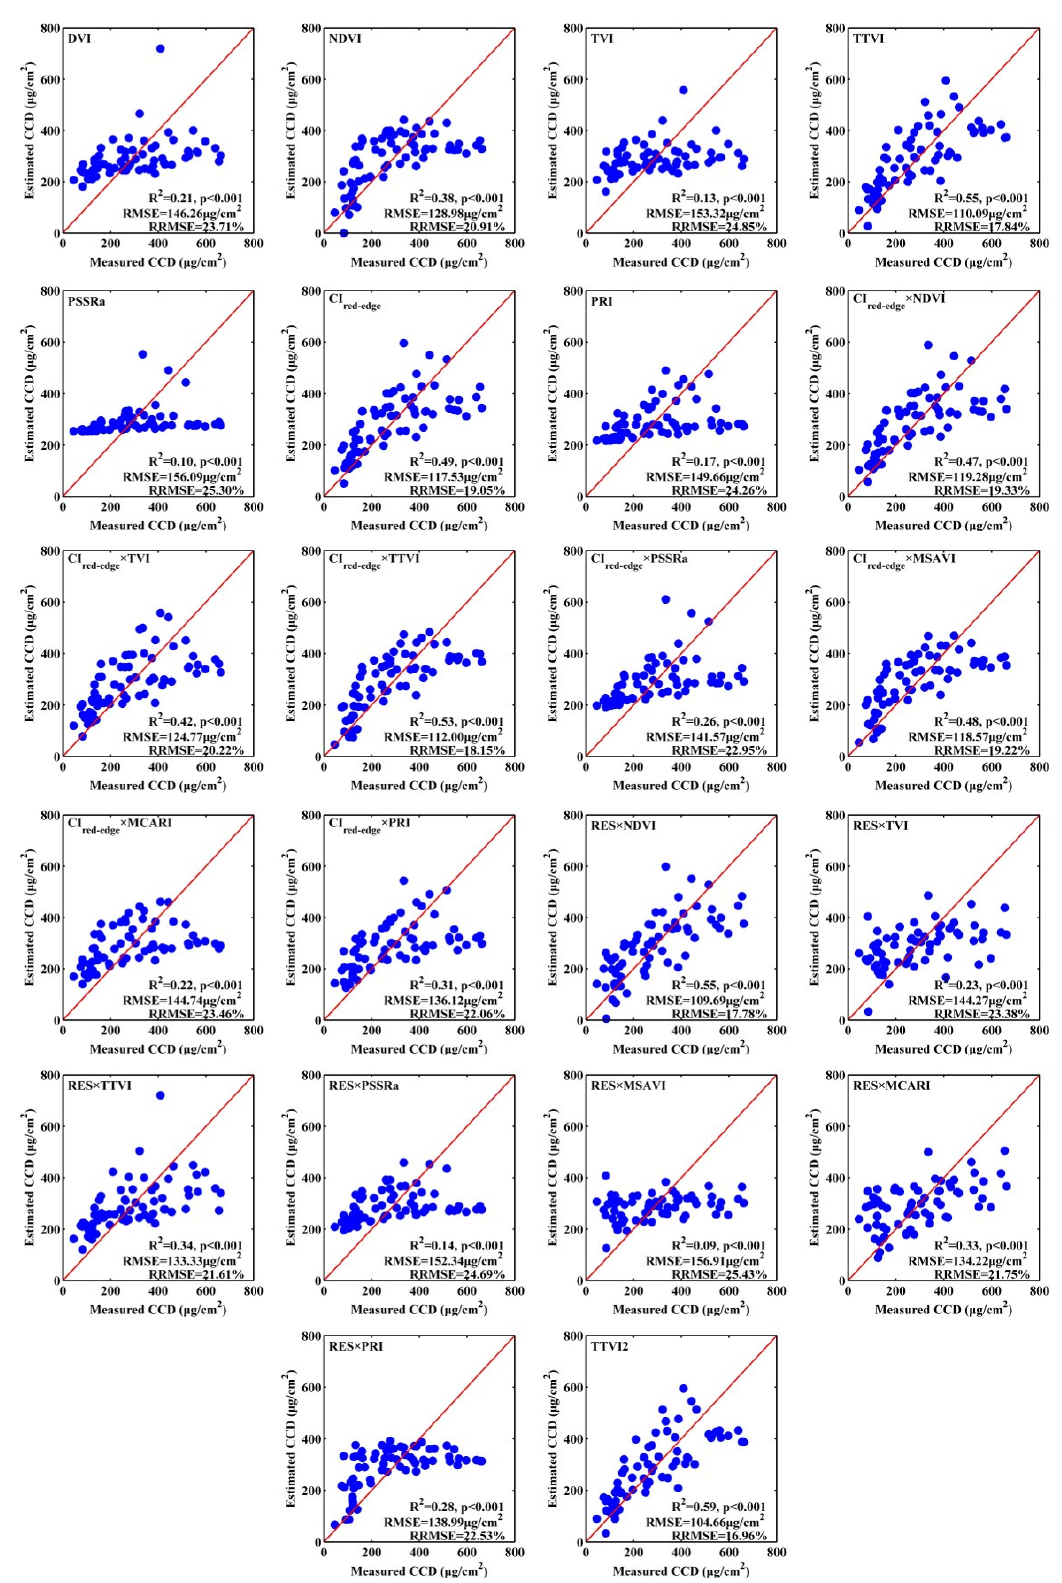
Figure 8. Scatterplots of the measured CCD versus the estimated CCD derived from ground hyperspectral vegetation indices. Red solid lines indicate 1:1 lines.